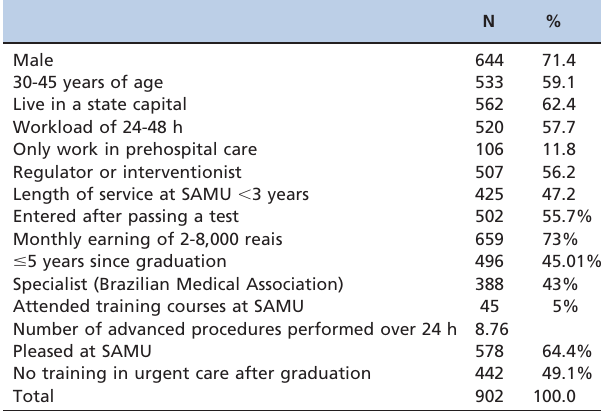
Table 1 - Descriptive characteristics of the profile of the physicians who work at